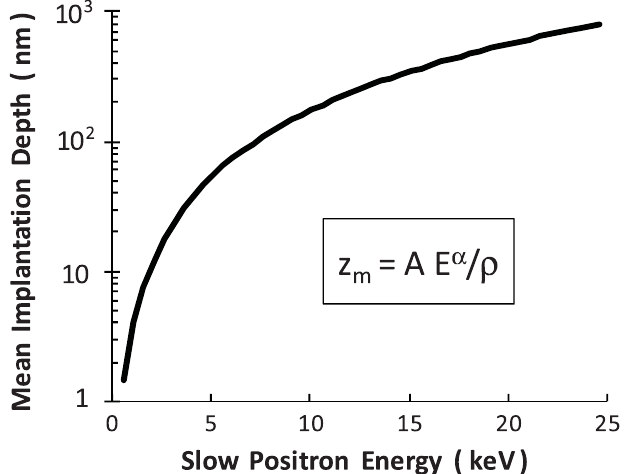
FIG. 5. Mean implantation depth in niobium versus positron beam energy.